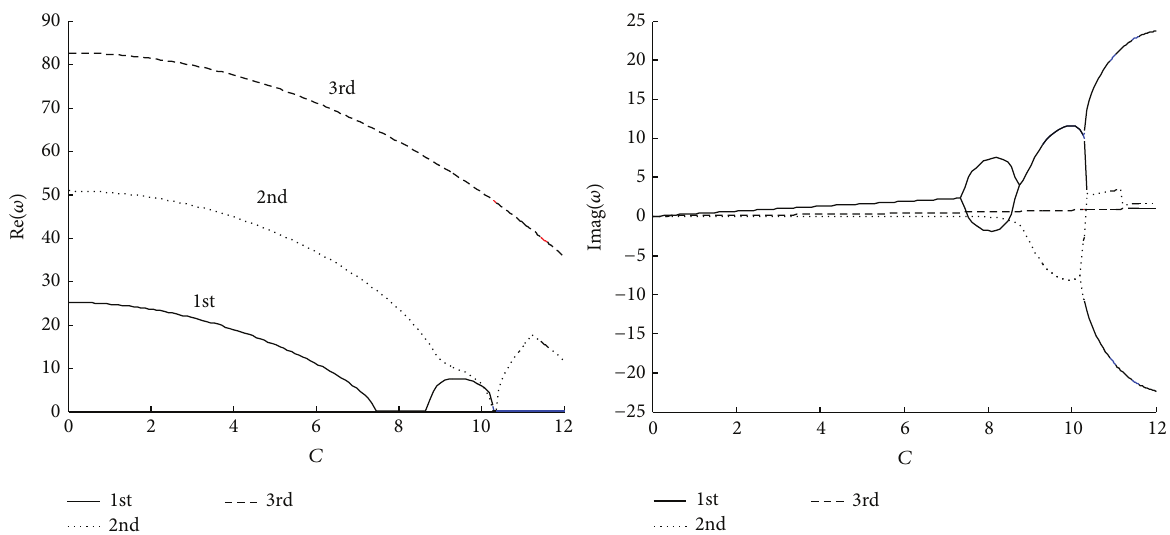
Figure 4: Dimensionless complex frequencies versus dimensionless axially moving speed 𝐶 ( 𝐻 = 10 −5 , 𝑞 = 50 , 𝑟 = 1 , 𝑈 = 20 , and 𝜆 = 0.05 ).